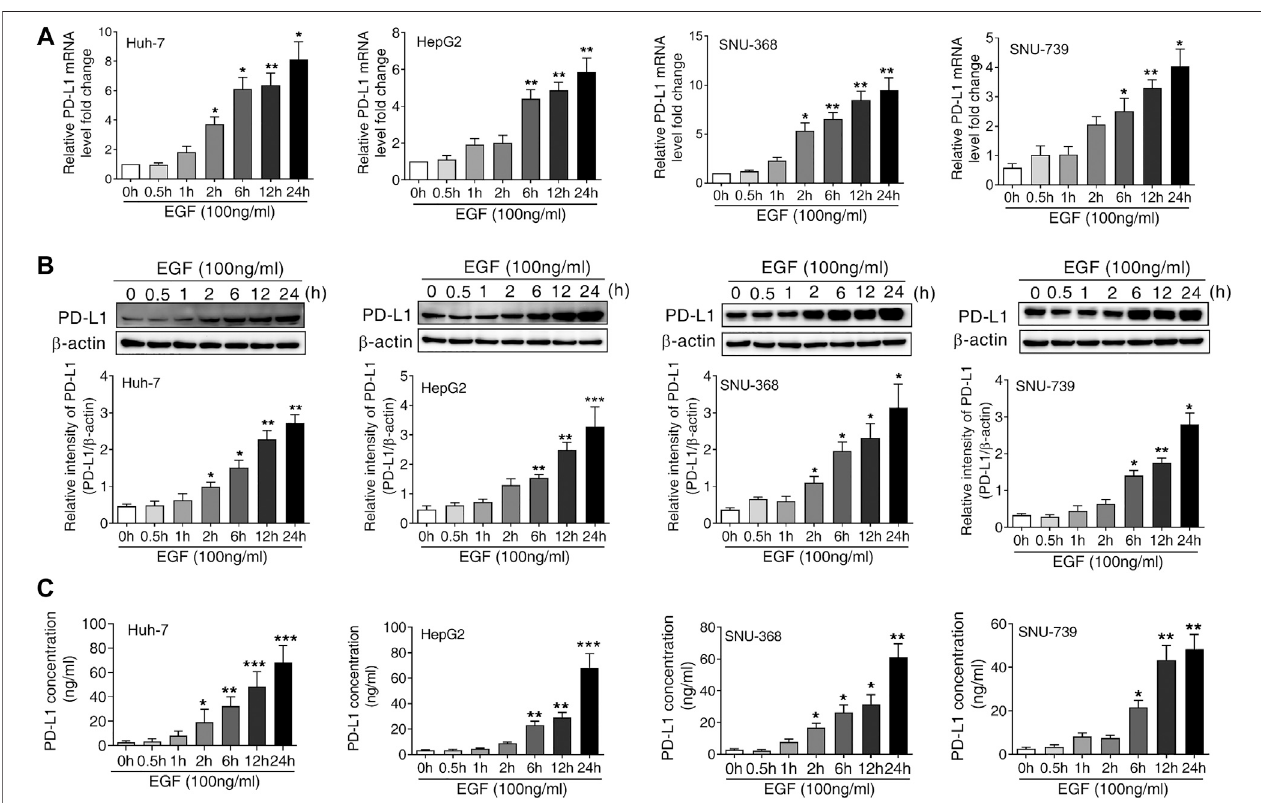
FIGURE1| EGFpromotesPD-L1expressioninhepatocellularcarcinomacells (AandB) Asigni fi cantincreaseinPD-L1mRNA (A) andproteinexpression (B) was observed in Huh-7, HepG2, SNU-368 and SNU-739 cells after treated with EGF for indicated time. *p < 0.05, **p < 0.01, ***p < 0.001 compared to control group, one- way ANOVA, n (cid:2) 5 independent experiments per group (C) The ELISA assay showed that the concentration of PD-L1 in the cell culture medium was increased after incubationwithEGFforindicatedtime, *p < 0.05, **p < 0.01, ***p < 0.001comparedtocontrolgroup,one-wayANOVA, n (cid:2) 5independentexperimentspergroup.